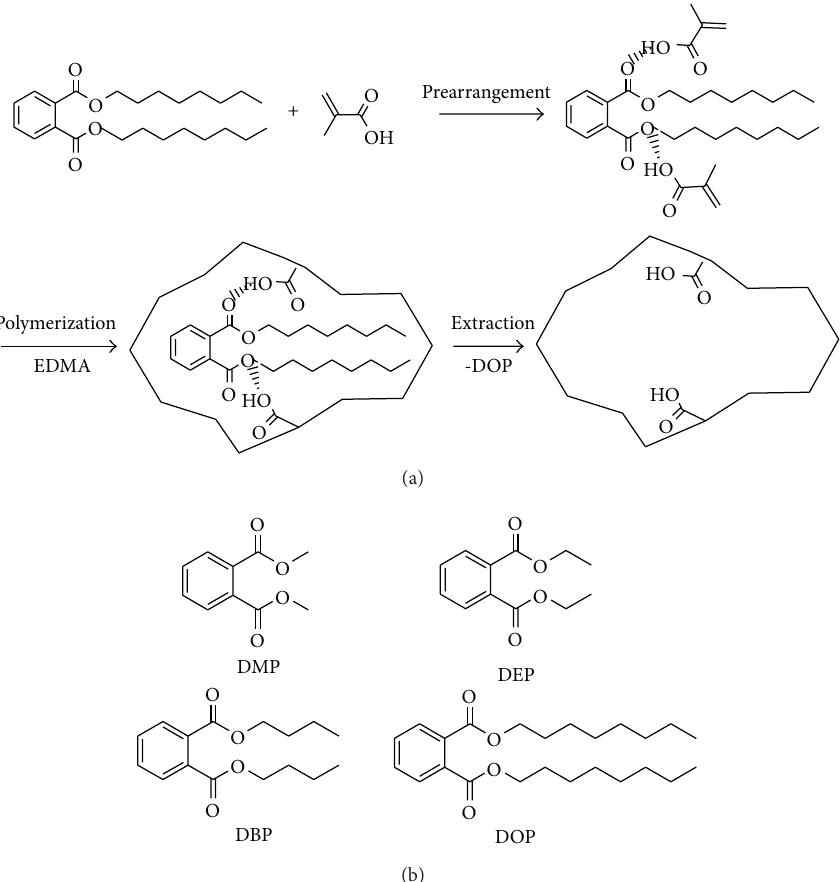
Figure 1: (a) Schematic illustrations of the imprint formation and molecular recognition. (b) Molecular structures of the related